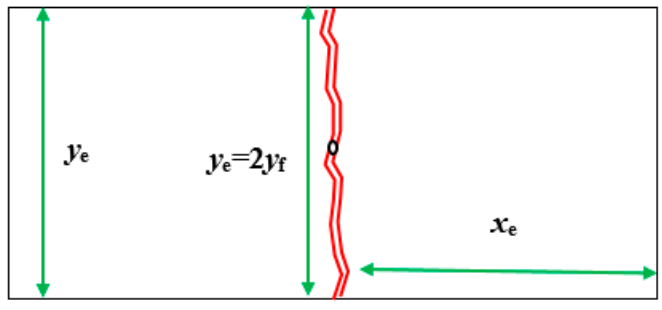
Figure 1. Diagram of one-dimensional fluid flow.